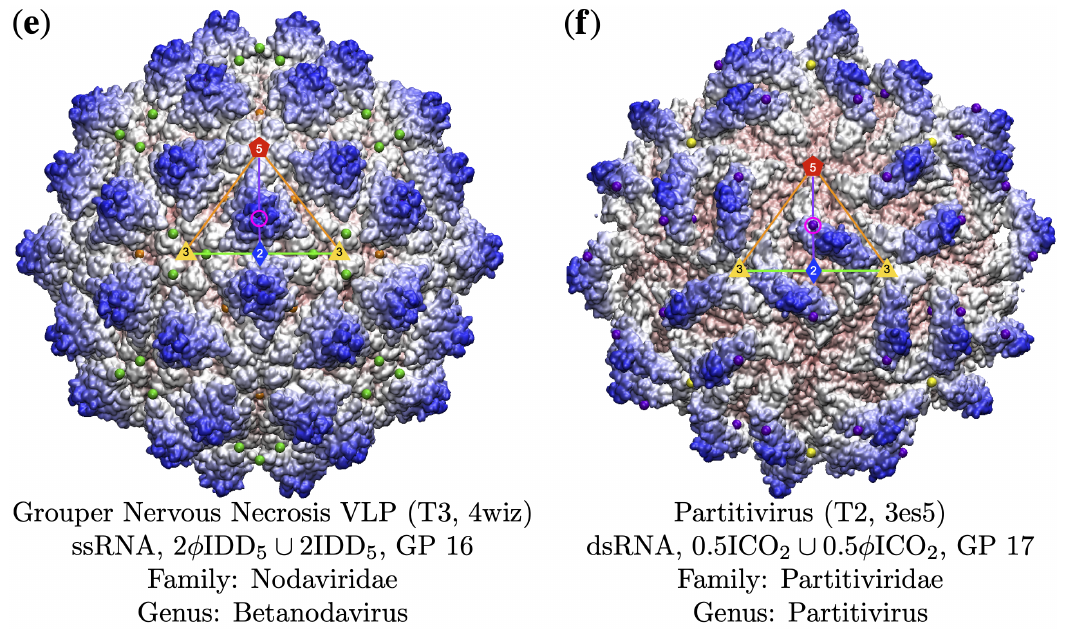
Figure 11. Gauge points 7 to 17 continued. This region is home exclusively to RNA viruses. ( e ) Grouper Nervous Necrosis VLP [57] uses GP 16 that is slightly embedded with the protrusion. Overall, this capsid does not have a great fit with the point arrays, as can be seen with the floating green points. ( f ) Partitivirus [58] has an unusual protrusion that connects to the viral surface in the bulk region; however, the edge of it intersects the 5–2 arc at GP 17.